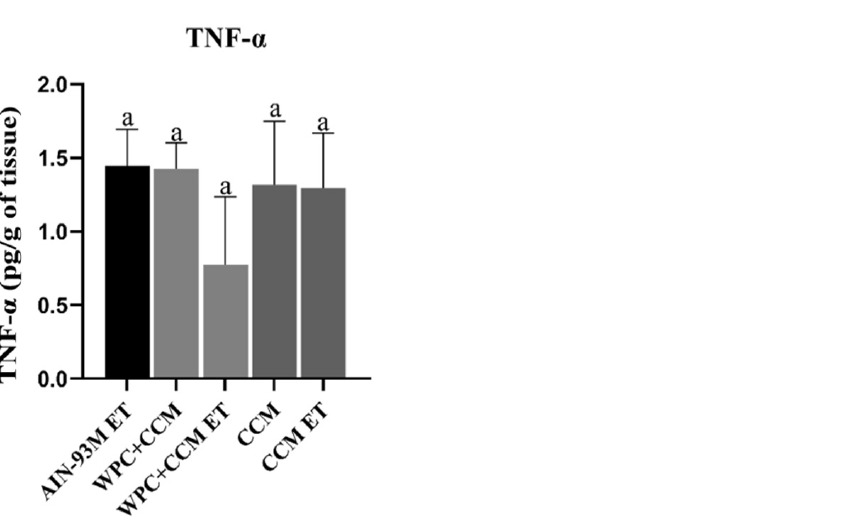
Table 4. Histopathology of the muscle of rats that were submitted or not to an exhaustive swimming test.